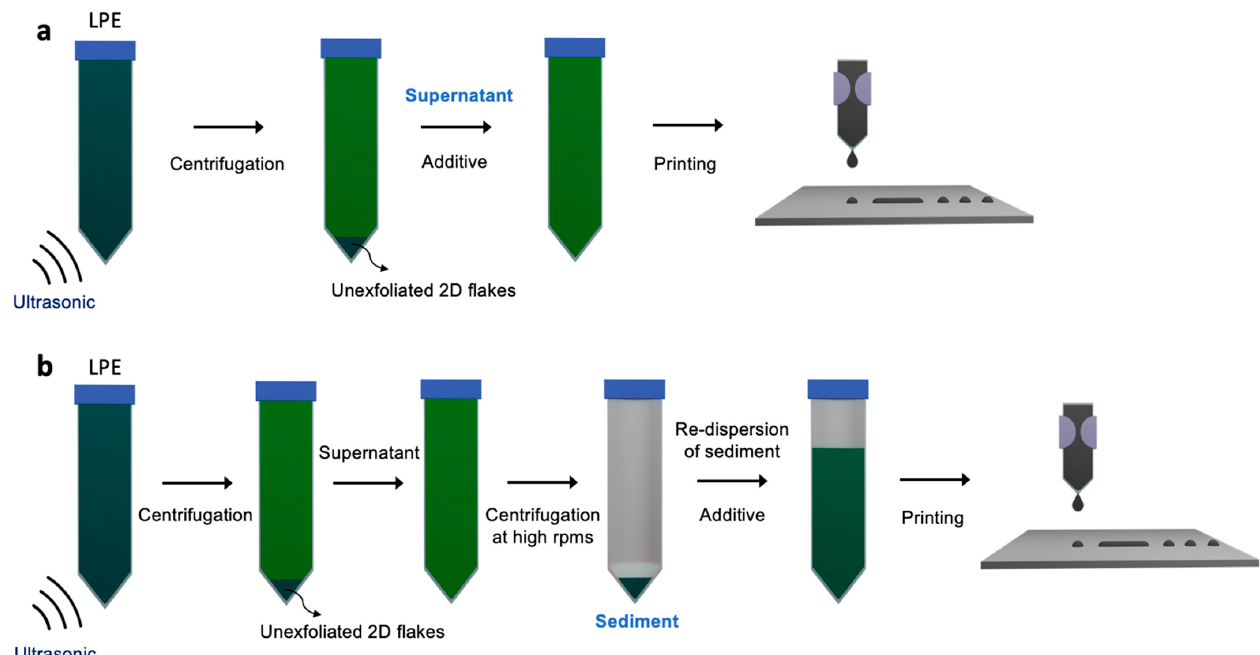
Figure 4. Schematic of ink formulation: ( a ) direct ink formulation and ( b ) solvent exchange ink formulation.